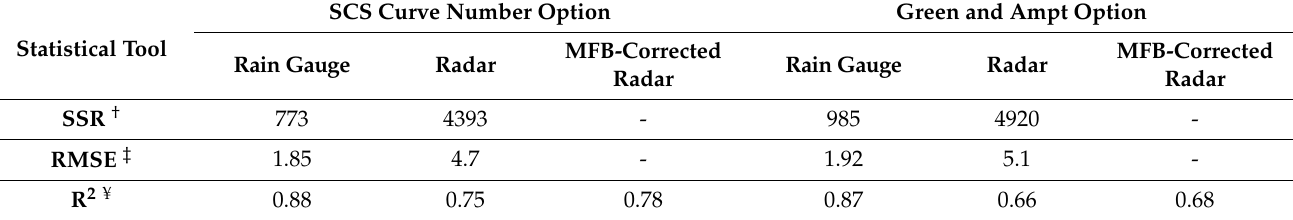
Table 13. Statistical comparison of stream flow using SCS curve number method and Green and Ampt method using different rainfall inputs. † Sum of Squared Residuals. ‡ Root Mean Squared Error. ¥ Coefficient of